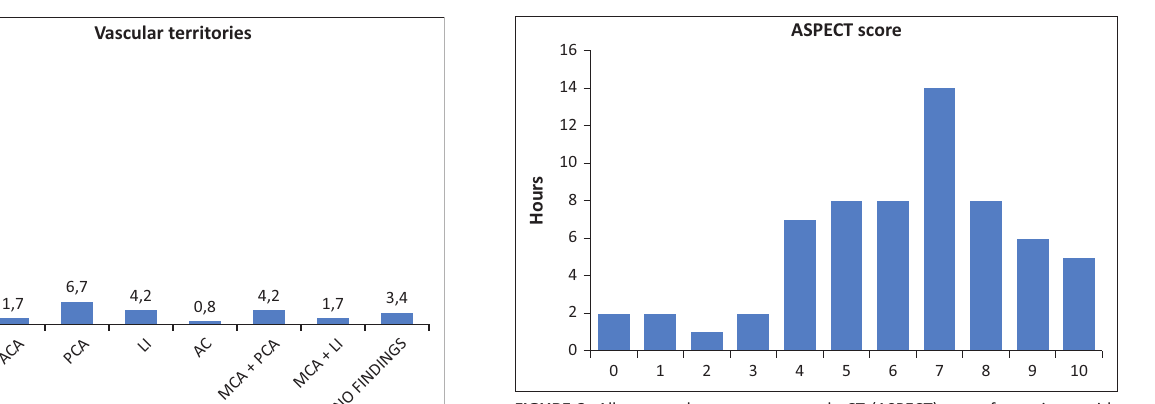
FIGURE 3: Alberta stroke programme early CT (ASPECT) score for patients with acute ischaemic strokes (< 24 hours) and known time from symptom onset ( n = 63). FIGURE 1: Vascular territories of ischaemic infarcts ( n = 118). TABLE 2: Order to report time and arrival to report time compared with international recommendations (American Heart